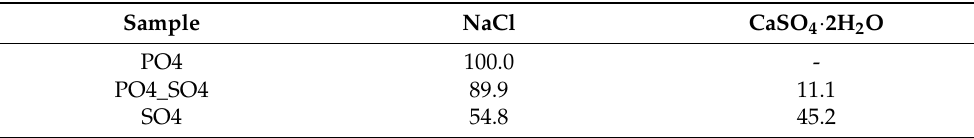
Table 2. The composition of the products isolated from the mother liquors after separation of the precipitate, wt. % **.